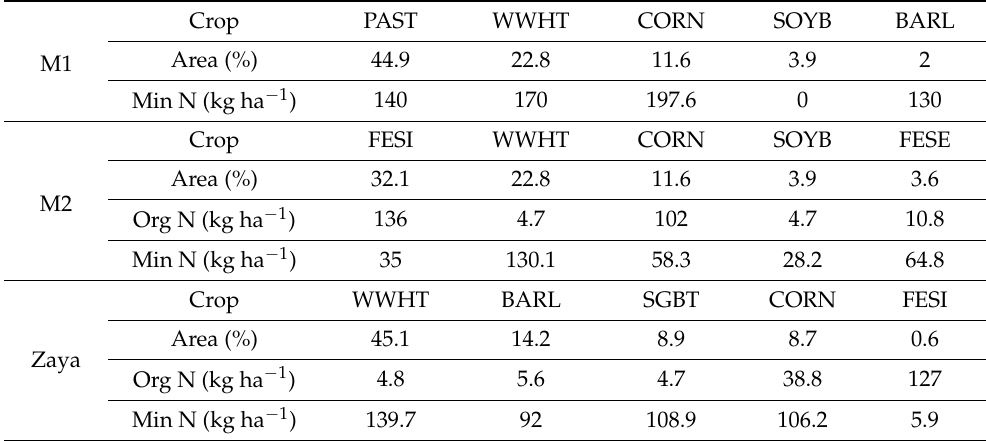
Table 2. Main crops categories, area and the amounts of applied N fertilizer in the Melk and Zaya catchments. Crop PAST WWHT CORN M1